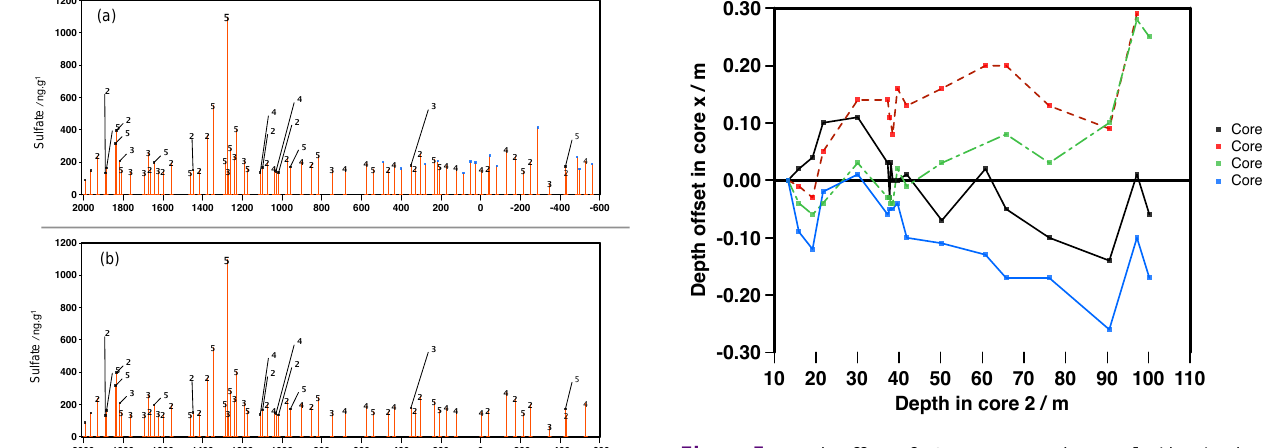
Figure 5. Depth offset of 18 common and securely identified vol- canic events in cores 1, 3, 4 and 5 relative to core 2. To overcome offset due to the drilling process and poor core quality in the first meters, UE 1809 (depth: ca. 13m) is taken as the origin and horizon